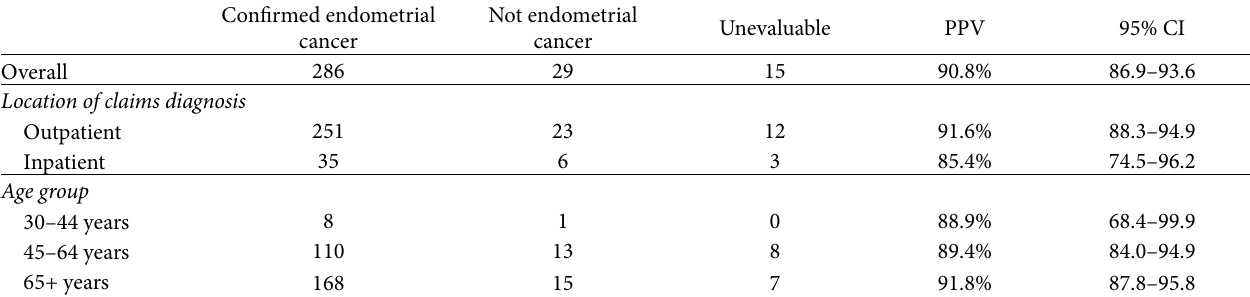
Table 2: Positive predictive values for endometrial cancer 𝑁 = 330